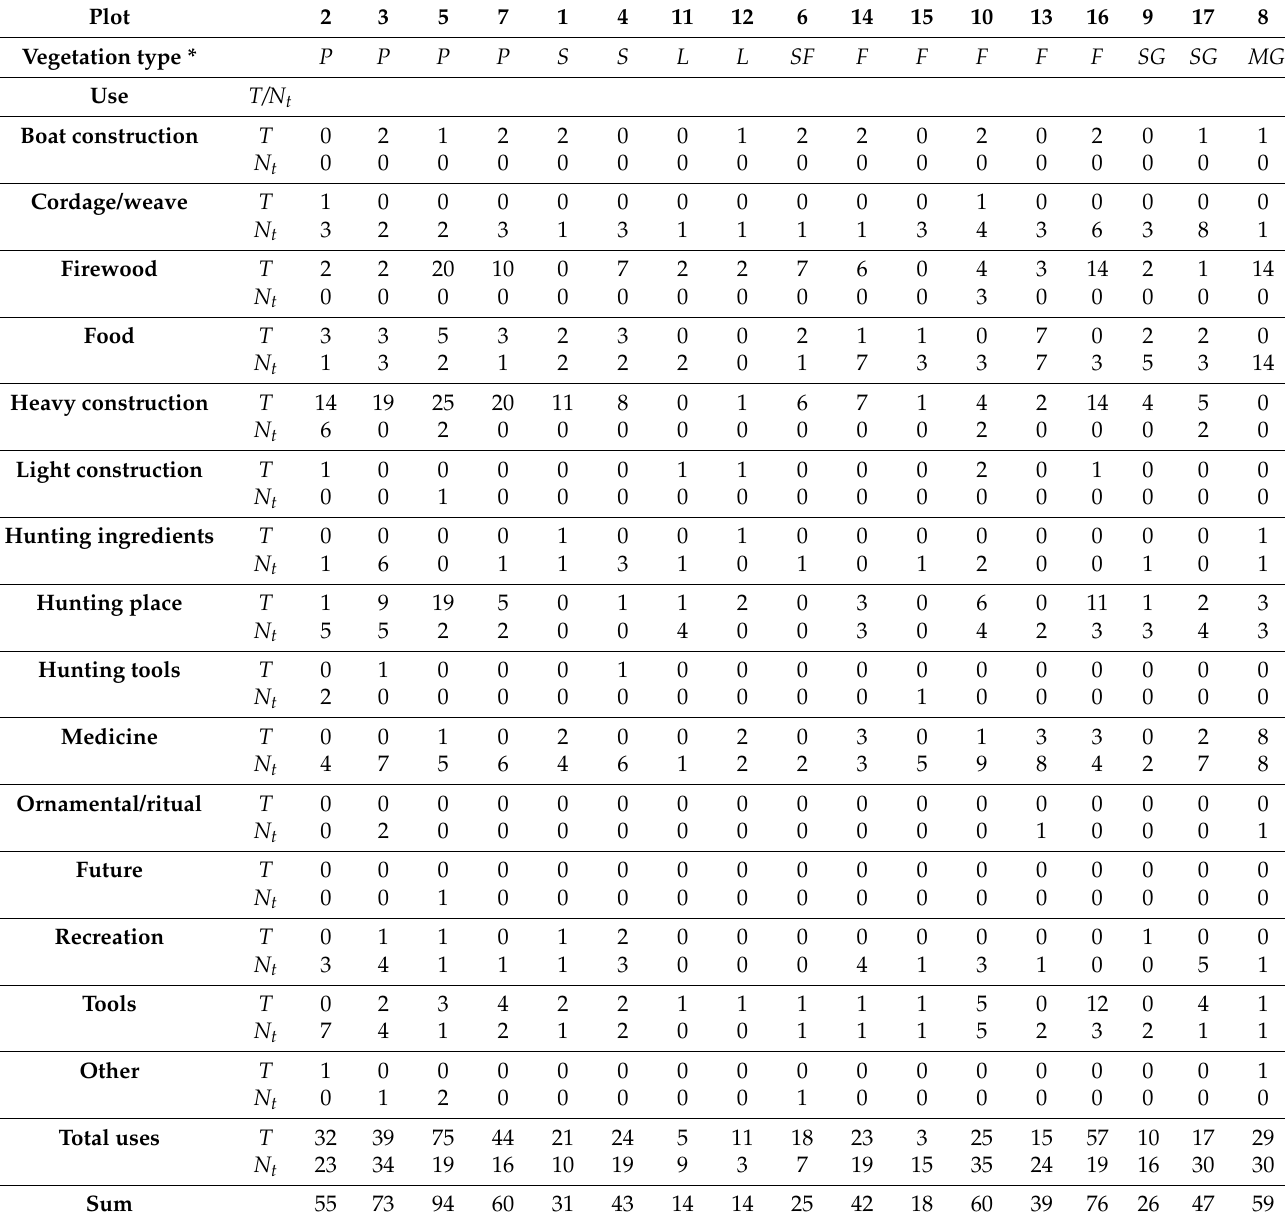
Table 4. Local uses and values recognized by local informants by category per plot per species, for tree ( T ) and non-tree ( N t ) plants. One species can have more than one value (see Table 1 for